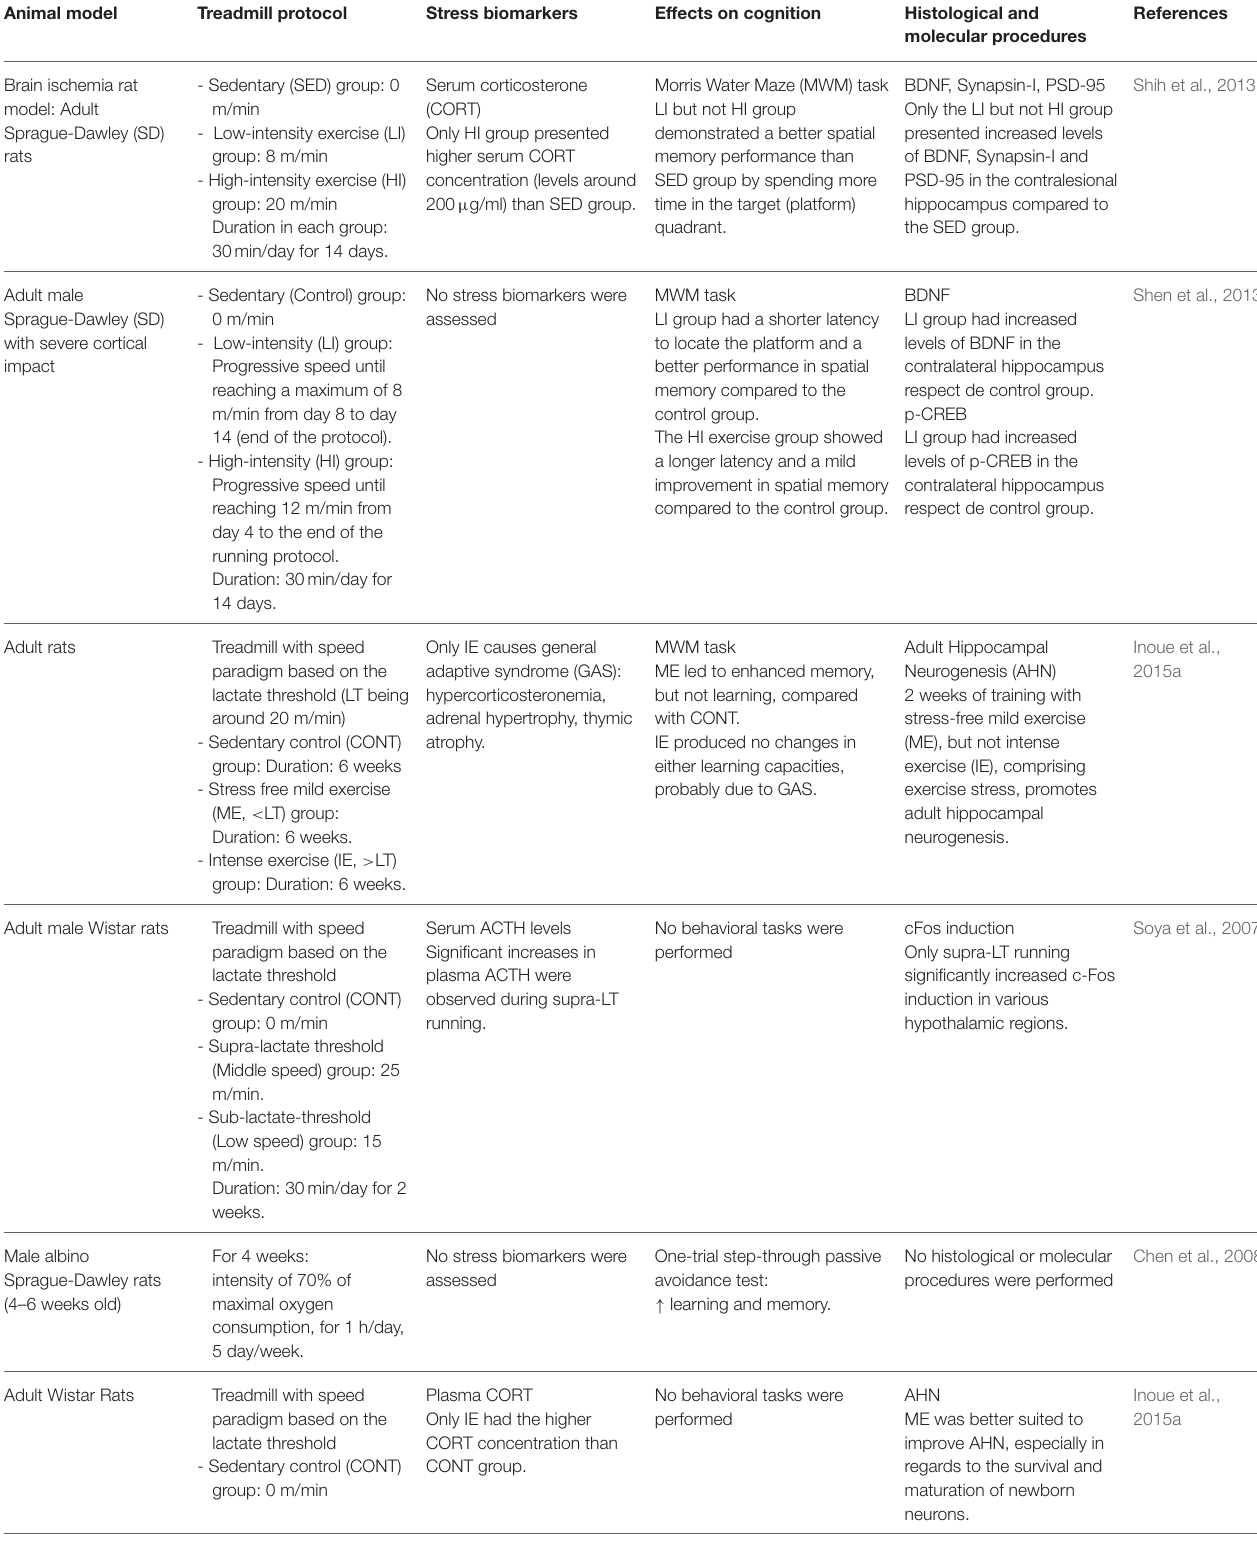
TABLE 1 | Examples of positive, lack of positive, and negative effects of different forced training intensities on stress, behavior, and neurogenesis. Animal